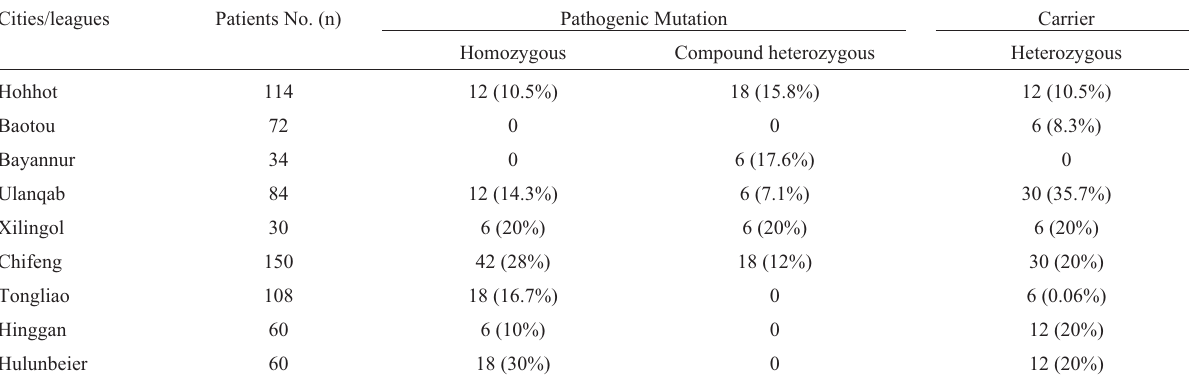
Table 4 - Patients with different deafness-related mutations from different cities/leagues in Inner Mongolia.